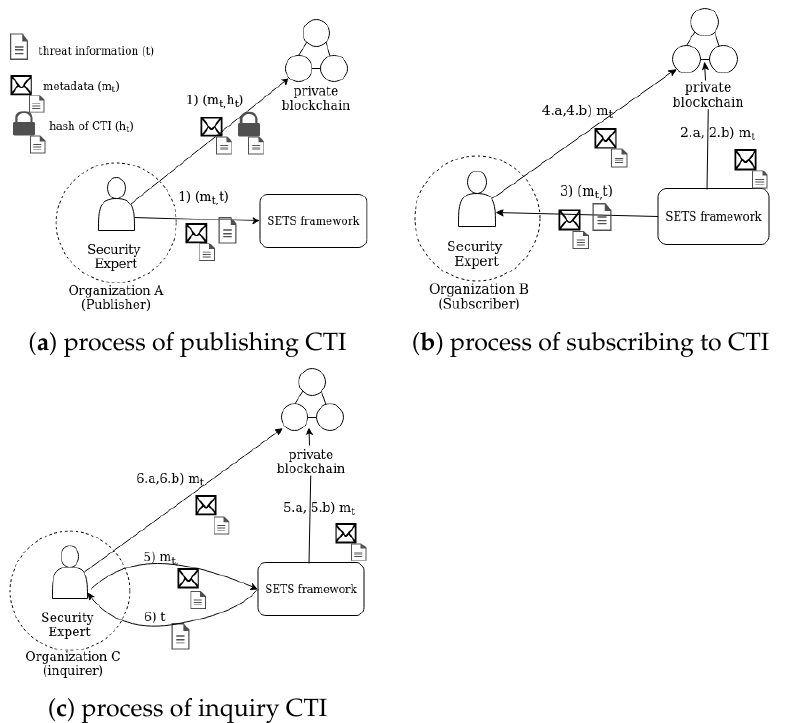
Figure 1. High-level view of the SETS framework. This figure illustrates how different compo- nents of the framework communicate with each other in the context of publishing, subscribing and inquiry